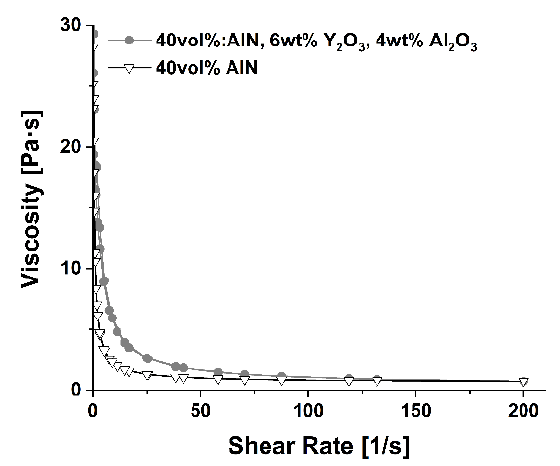
Figure 3. Viscosity comparison of 40 vol % dispersion with and without sintering additives.